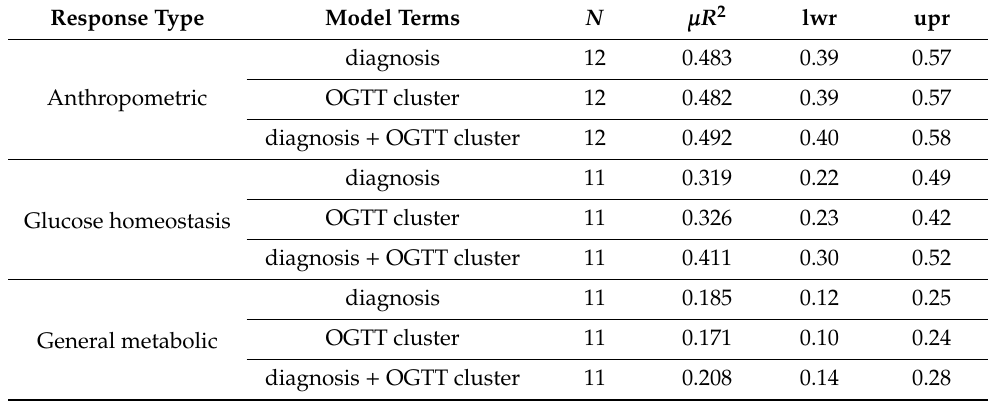
Table 3. The amount of variation in total time-series data explained by repeated measures mixed models including diagnosis, OGTT cluster, or both for the di ff erent response types. The parameters included for each response type are listed in Table 1. A separate model was fit for each response parameter, a marginal R 2 calculated for each, and then averaged within response types. N is for the number of response variables within a response type to which a model was fit; µ R 2 is mean marginal coe ffi cient of multiple determination; lwr is the lower 95% confidence limit; upr is the upper 95% confidence